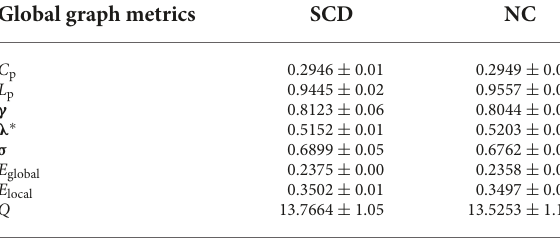
TABLE 2 Statistical result of graph metrics between the two groups.